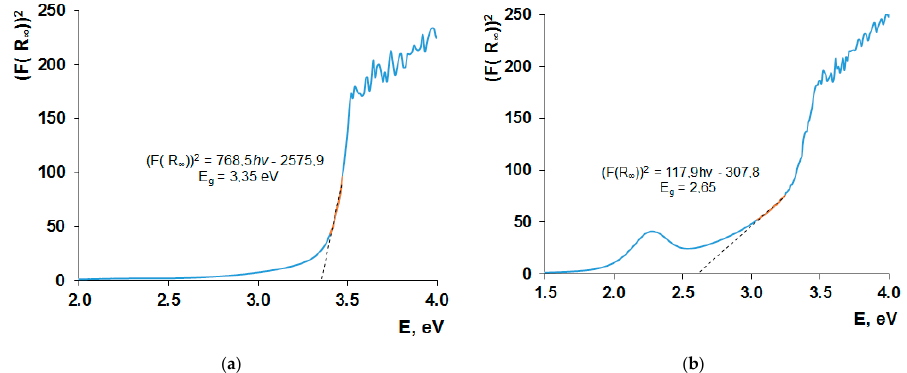
Figure 15. Kubelka-Munk function of samples with compositions [( ≡ TiO) n ]:[HEMA] = 1:6 ( a ) and [( ≡ TiO) n ]:[HEMA]:[AN] = 1:5:1 + Ag NPs ( b ).